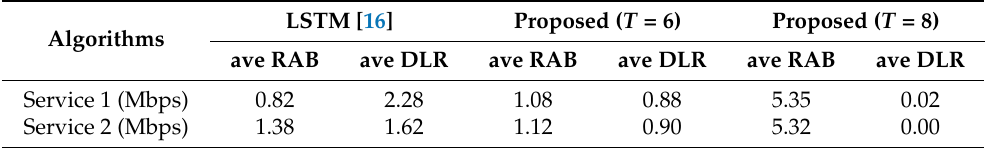
Table 8. The average DLR and RAB values of the proposed GRNN algorithm with T = 6 and T = 8, and its LSTM [16] counterparts for source data rate prediction for various services.